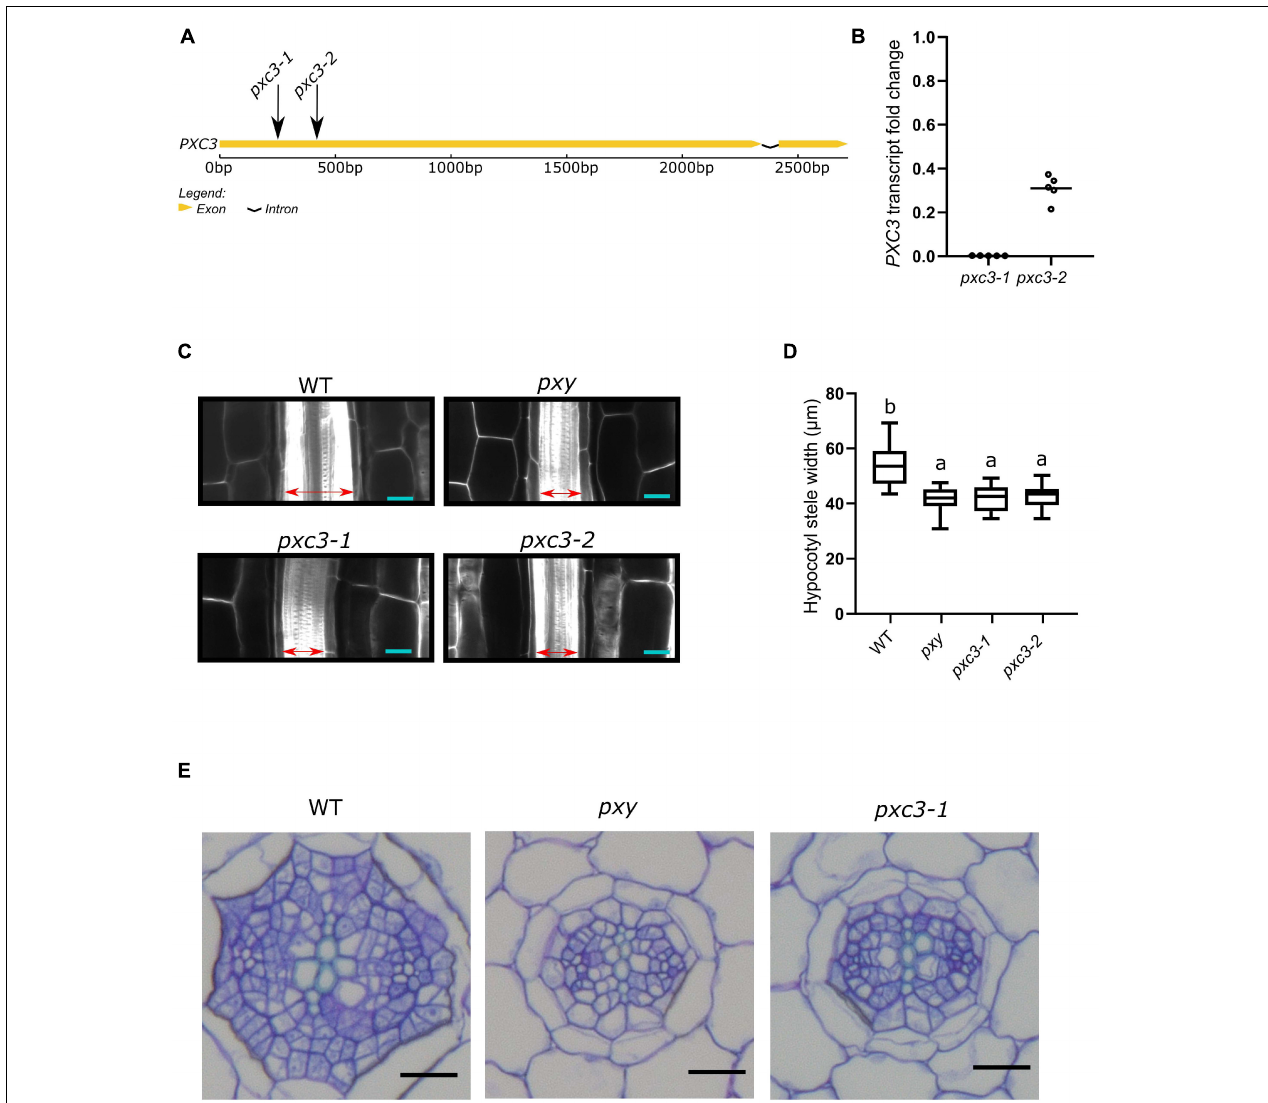
FIGURE 2 | pxc3 mutants have reduced stele in the hypocotyl of Arabidopsis seedlings. (A) Structure of PXC3 gene. The arrows indicated the approximate position of the T-DNA insertion in pxc3 mutants. (B) PXC3 expression levels in pxc3-1 and pxc3-2 mutants compared to wild type determined by qPCR in 5 independent biological replicates (individual data points). Transcript fold change relative to wild type is shown. (C) Longitudinal confocal sections of wild type and mutant hypocotyls (7 DAG seedlings). The double-sided arrow indicates the stele width. Scale bars represent 20 µ m. This experiment was done three times with similar results. (D) Quantification of the stele width in wild type and mutant hypocotyls ( n ≥ 15). One-way ANOVA followed by Tukey’s test was performed, and the lowercase letters indicate statistical differences ( P < 0.05). (E) Cross-section of wild type and mutant hypocotyls (7 DAG seedlings). Scale bars represent 20 µ